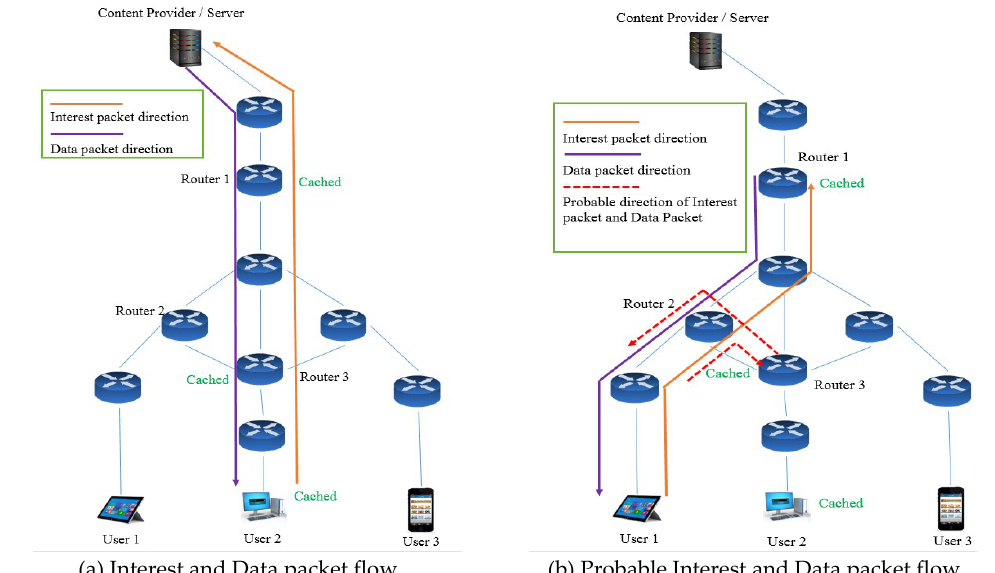
Figure 5. The problem with on-path caching.